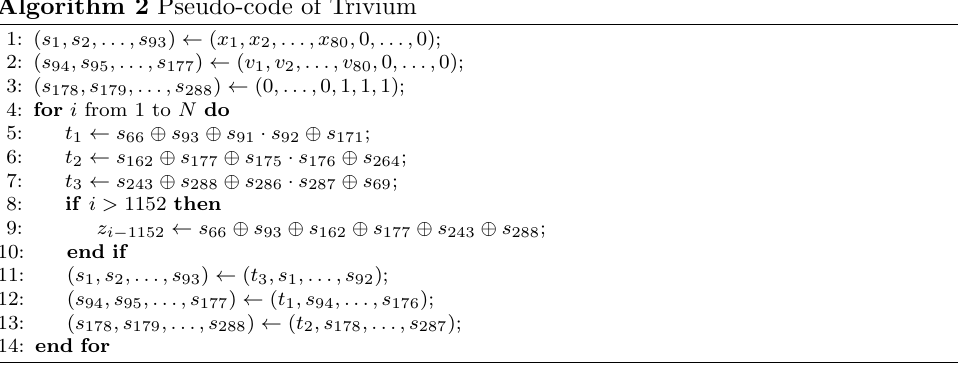
Algorithm 2 Pseudo-code of